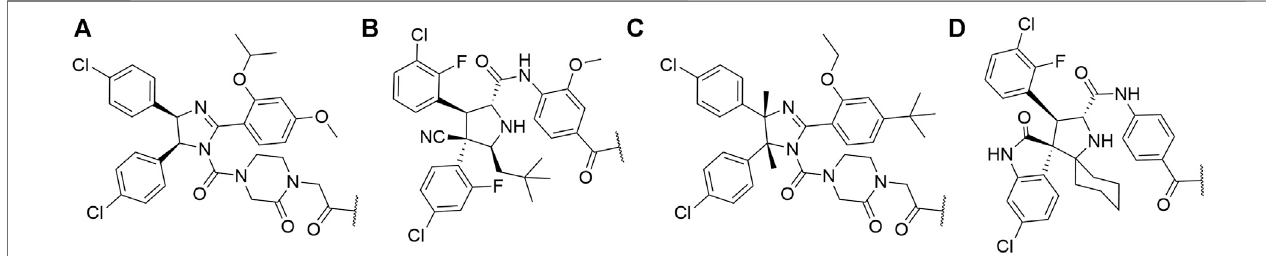
FIGURE 8 | MDM2 ligands. (A) Nutlin-3a derivative, (B) Idasanutlin derivative, (C) RG7112-derivative, (D) MI-1061 derivative.